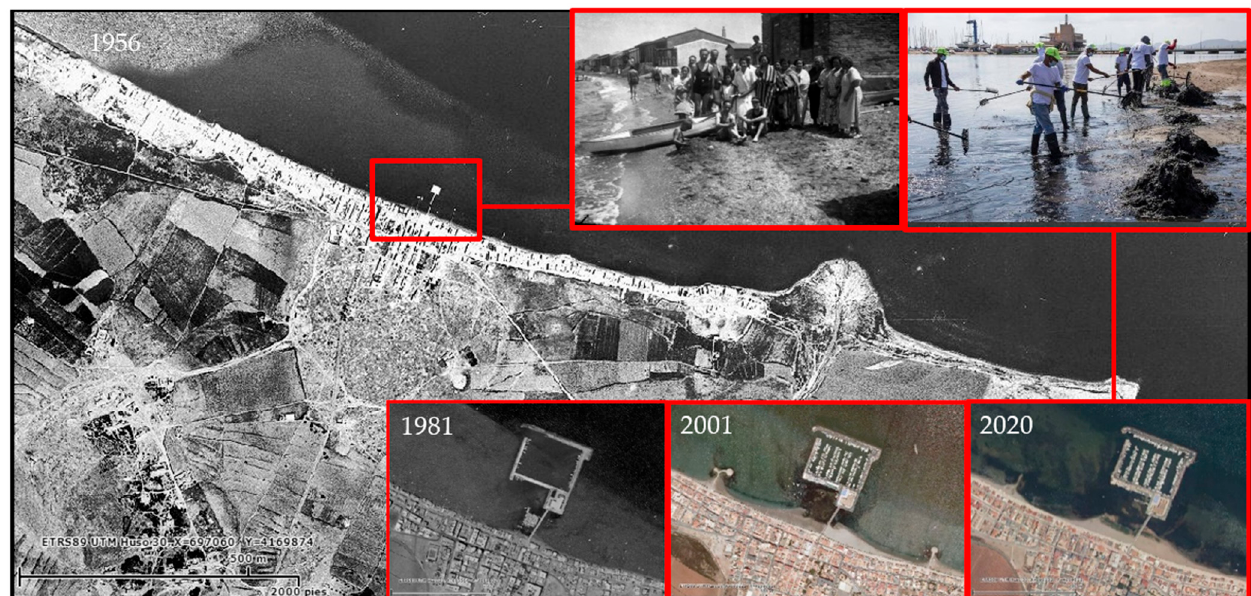
Figure 8. Los Nietos island harbor’s evolution from 1956 to 2020. Source: Sistema de Información Territorial de la Región de Murcia.